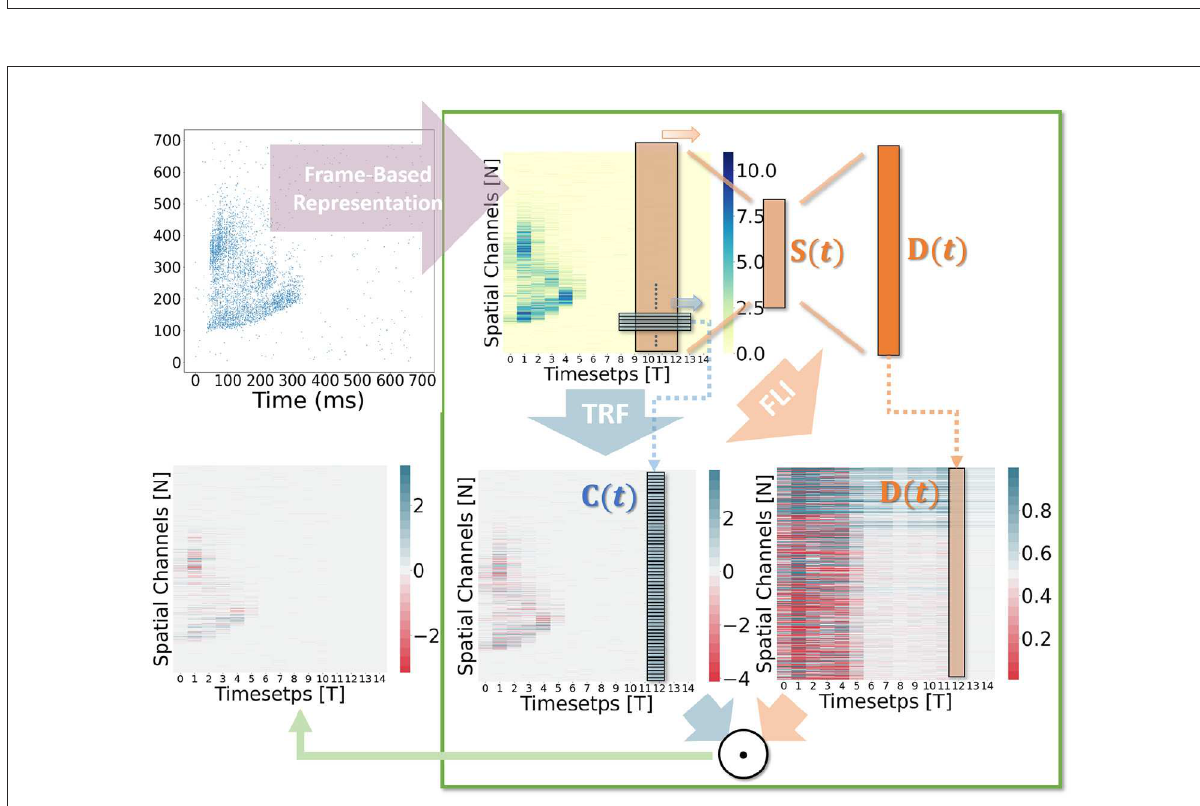
FIGURE5 Computation visualization. The input is an audio sample from the SHD